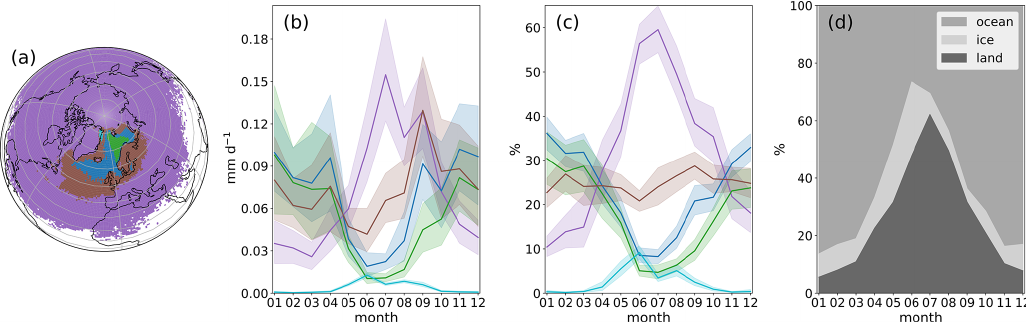
Figure 7. (a) K -means clustering of grid points into five clusters. The annual cycle of mean contributing moisture sources to the precipitation in the study region is plotted for each cluster in (b) absolute and (c) relative number. Shaded areas represent the 95% confidence interval of the mean. In (d) , relative moisture source contributions from the ice-free ocean (sea ice concentration < 0.5), the sea ice (sea ice concentra- tion ≥ 0.5), and the land areas (same thresholds for land–sea mask) are depicted. The values for the sea ice concentration and hence the sea ice areas change throughout the months and years.